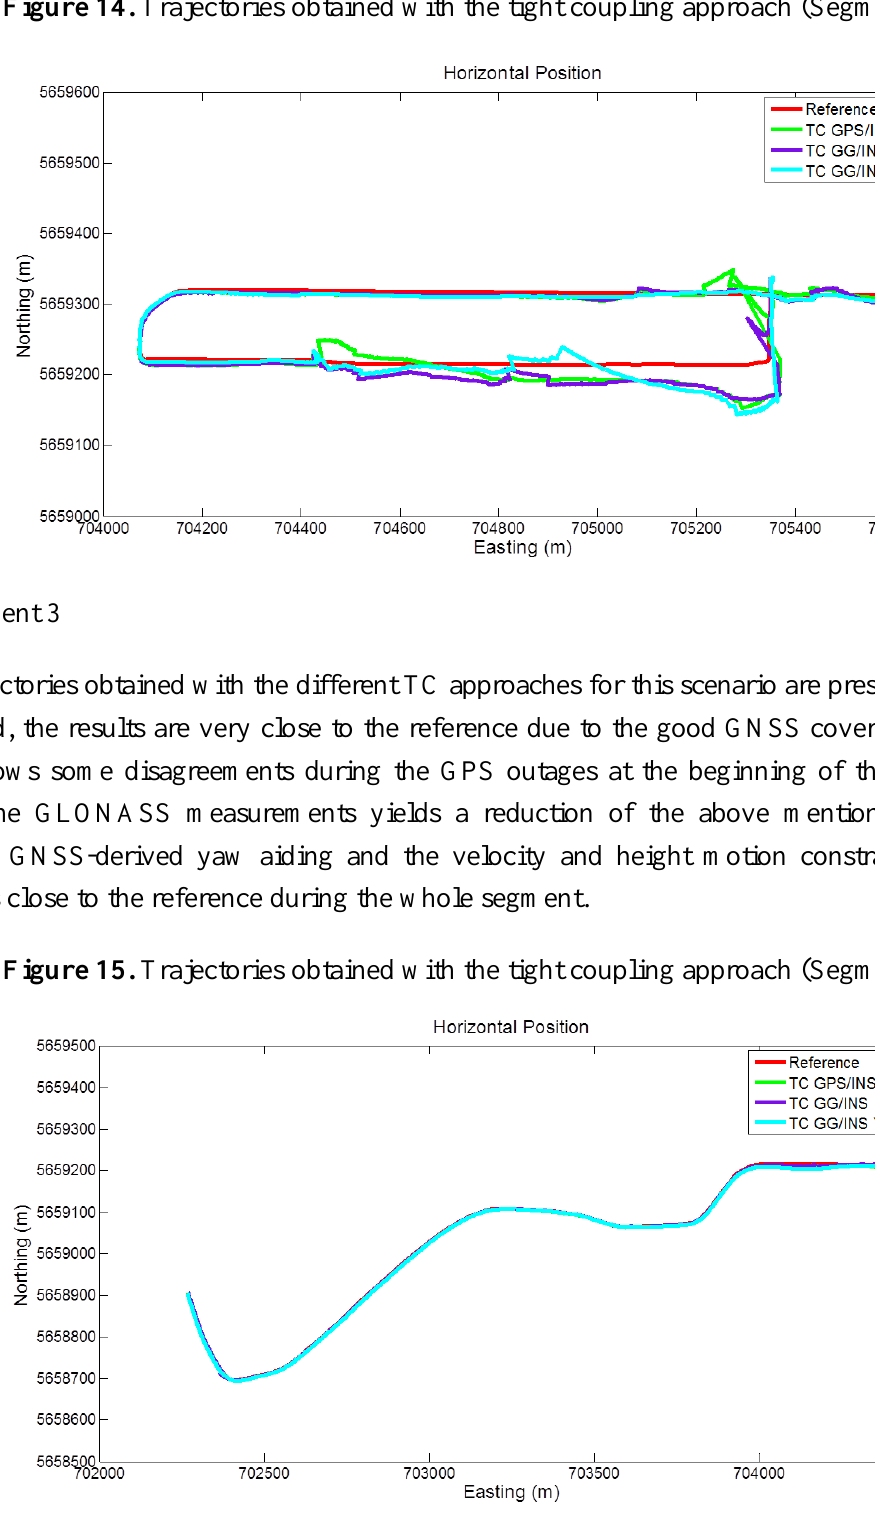
Figure 14. Trajectories obtained with the tight coupling approach (Segment 2).